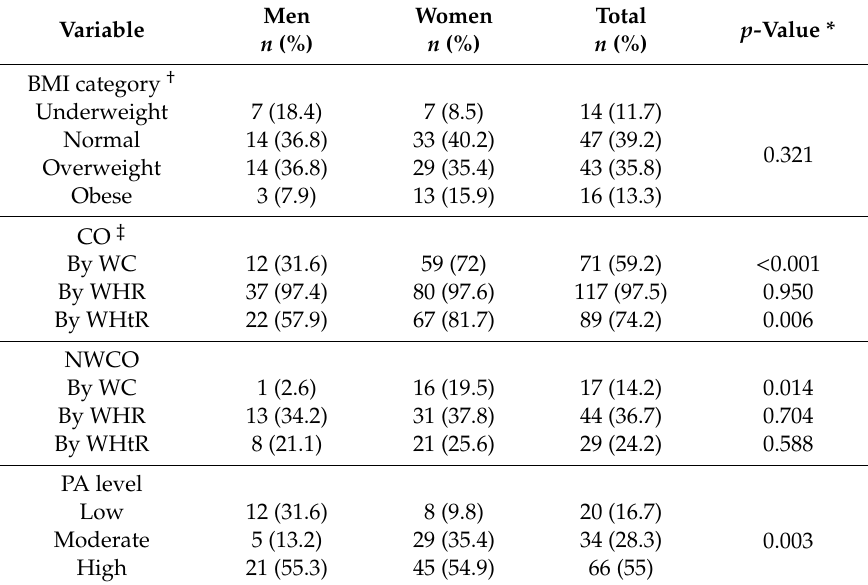
Table 3. Distribution based on BMI, CO, NWCO and PA by